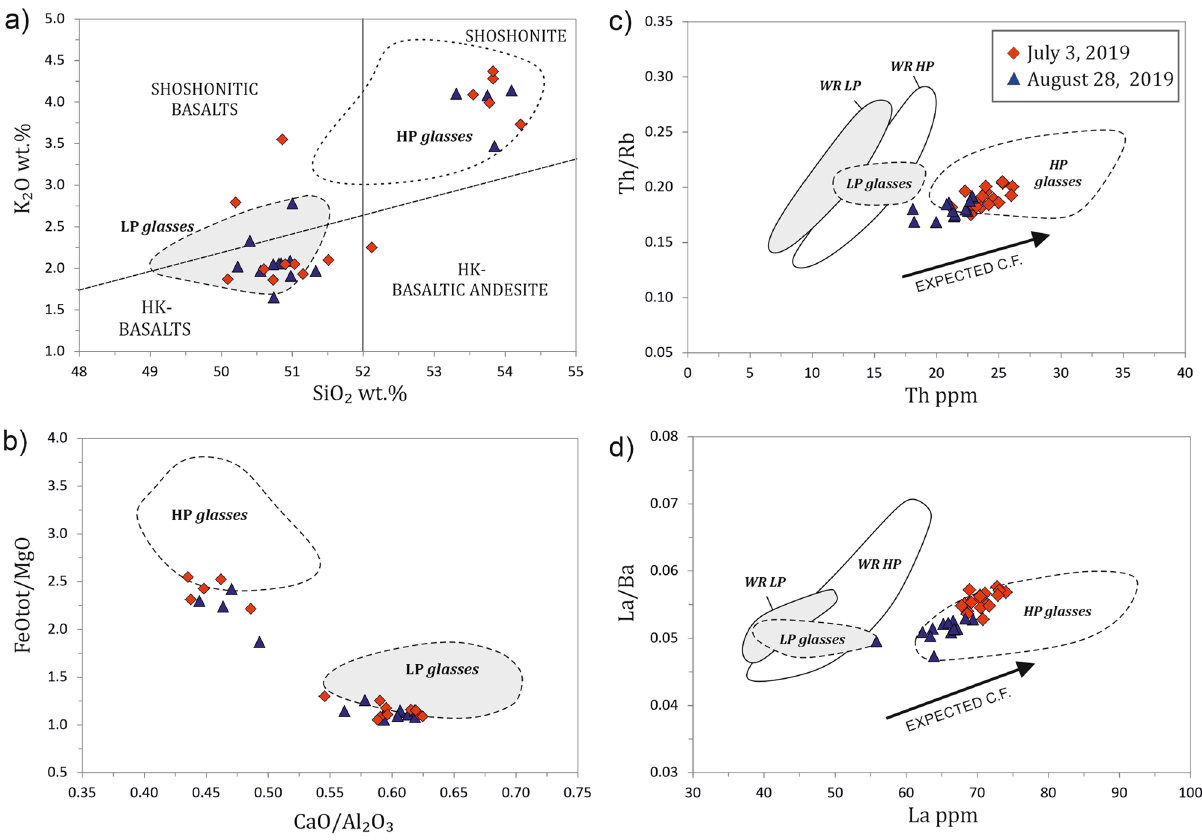
Figure 2. Representative diagrams for major and trace element compositions of the glassy matrix in tephra of the July 3 and August 28, 2019 eruptions: ( a ) SiO 2 vs. K 2 O; ( b ) CaO/Al 2 O 3 vs. FeO tot /MgO; ( c ) Th vs. Th/Rb; ( d ) La vs. La/Ba. In diagrams ( a ) and ( b ), the 2019 glass compositions are shown together with compositional fields for HP (white) and LP (light gray) glasses emitted during large scale paroxysms since the fifteenth century. Data are from Refs. 29,33,36,90 , and refer to anhydrous values. In diagrams ( c ) and ( d ), the July 3 and August 28, 2019 glass compositions are plotted together with the compositional fields for both HP and LP glasses (dashed lines) and whole rocks (WR; solid lines). HP and LP fields refer to compositions of pumice and scoria of paroxysmal eruptions from 1998 to 2005 (data from Refs. 29,44,62,92 ). C.F.: crystal